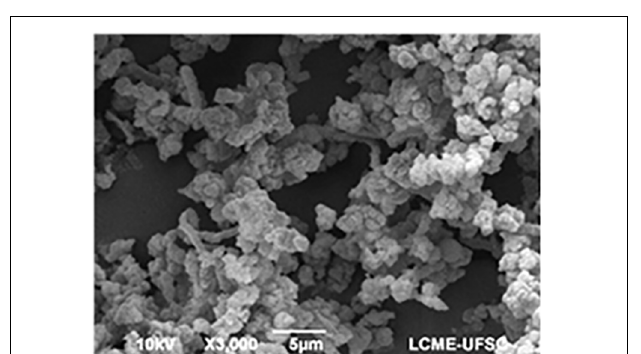
FIGURE 3 | FTIR-ATR spectrum of panels of AA1200 coated with neat e-coat and e-coat/PPy 0.4%, 0.8%, and 1.2% by